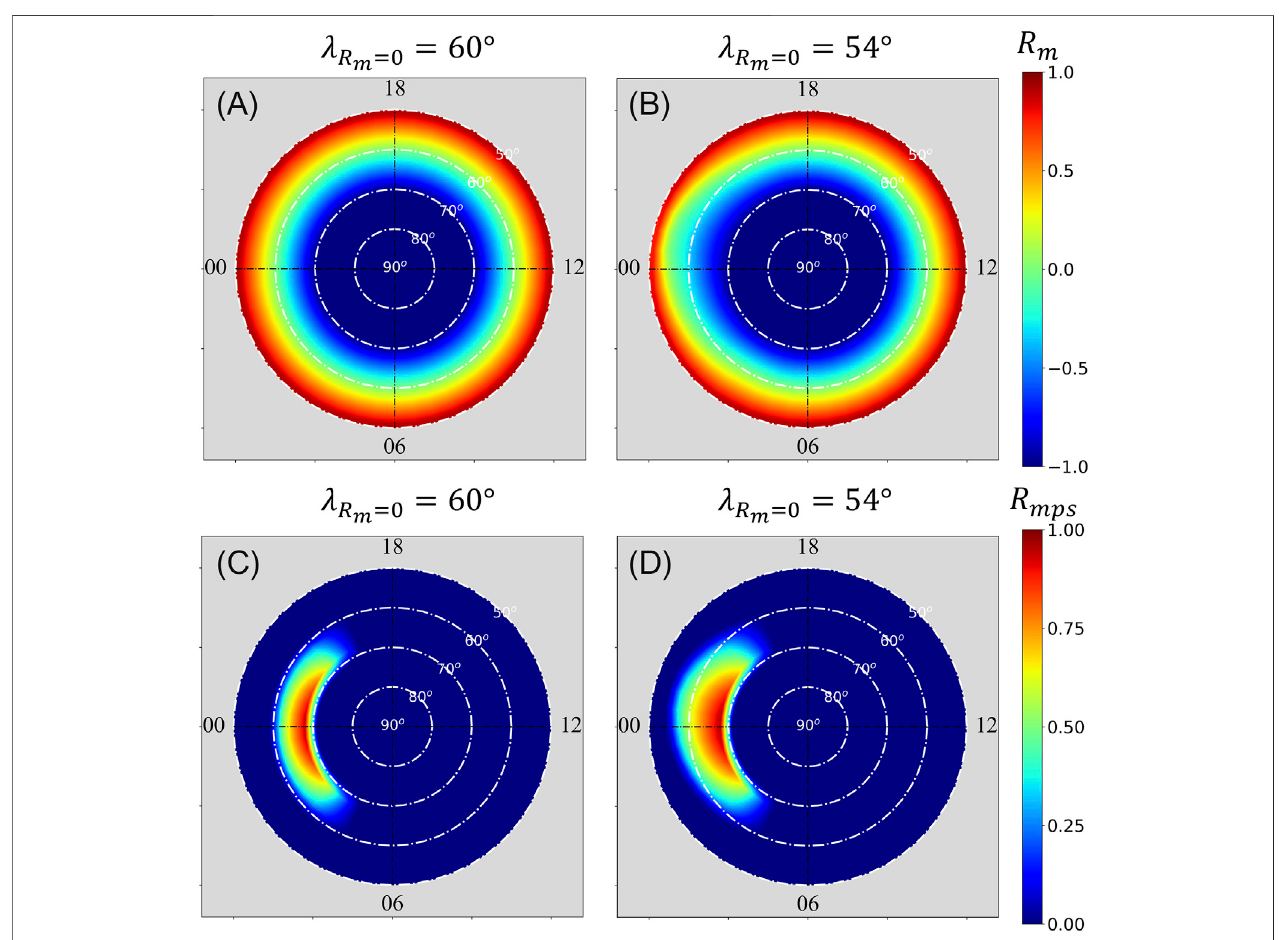
FIGURE1| Color-levelplotsof R m and R m (cid:1) 60 ° and 54 ° , respectively. Panels (C) and (D) show the distributions of R of R m with λ R m (cid:1) 0